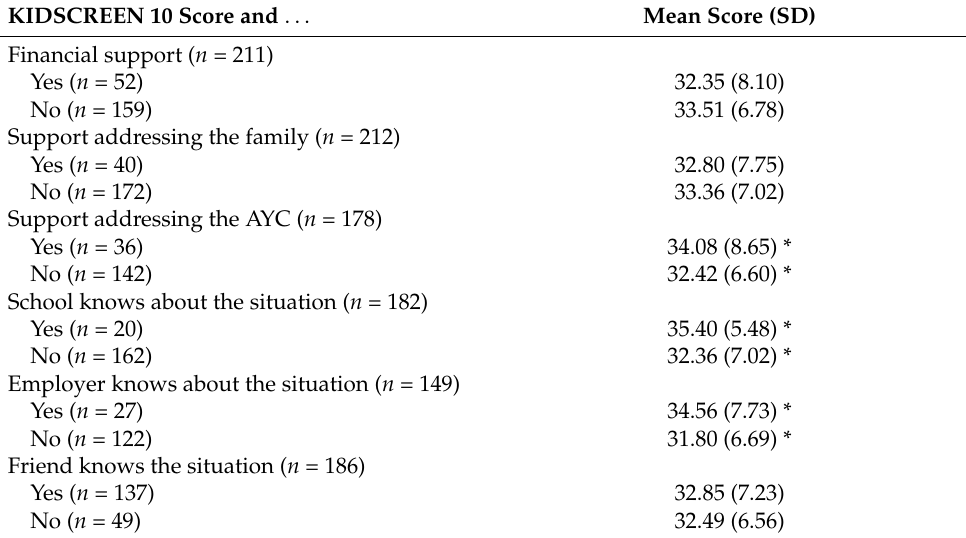
Table 4. Comparisons in the mean KIDSCREEN 10 score (SD) based on receiving support. KIDSCREEN 10 Score and . .